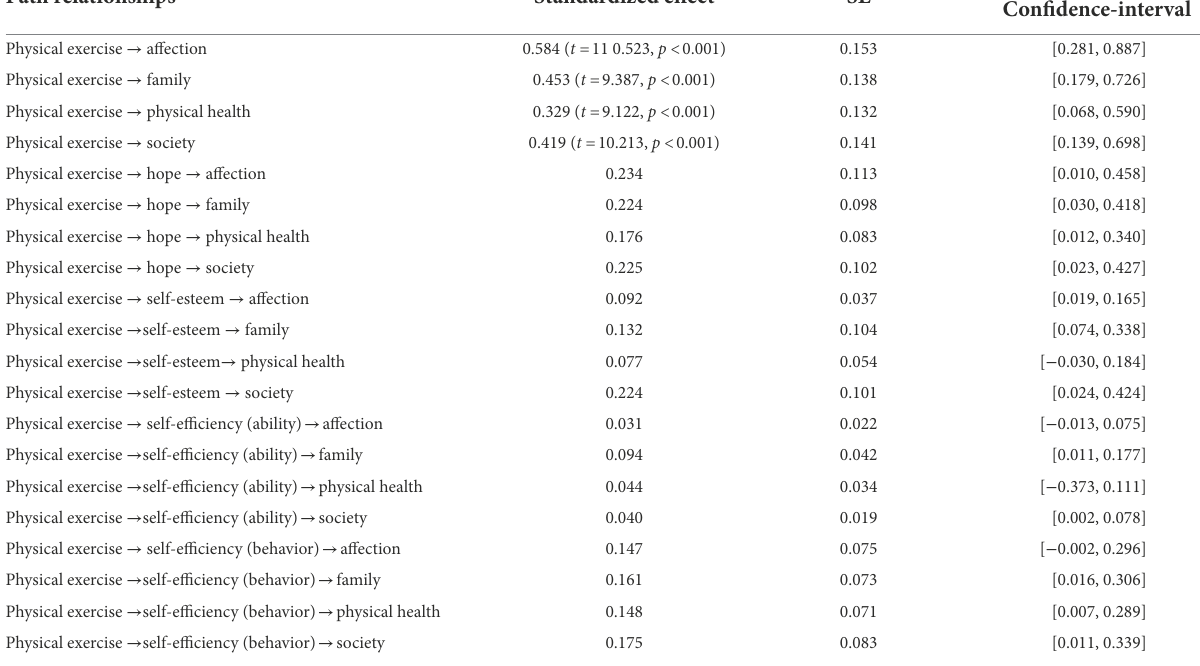
TABLE 5 Results of regression analysis. Path